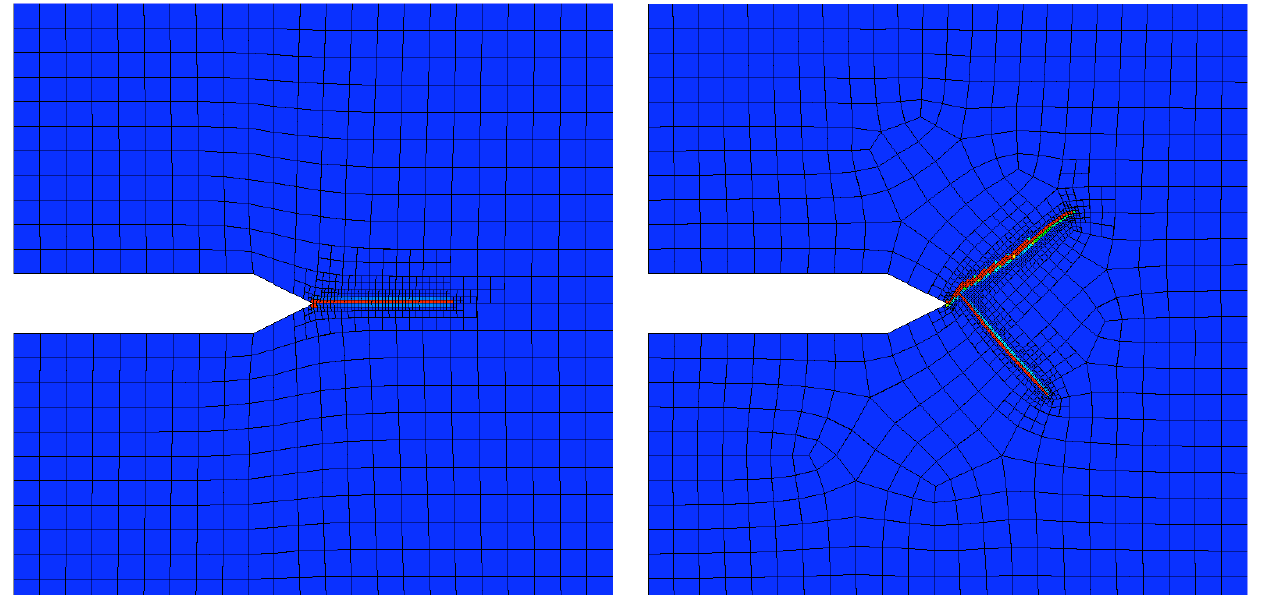
Figure 12 . Damage field solutions using the energy release rate refinement algorithm, but with G cr three times larger than the value used to find the solutions in Figures 10(c)–10(d). Clearly, the ability of the algorithm to mitigate the mesh dependence is